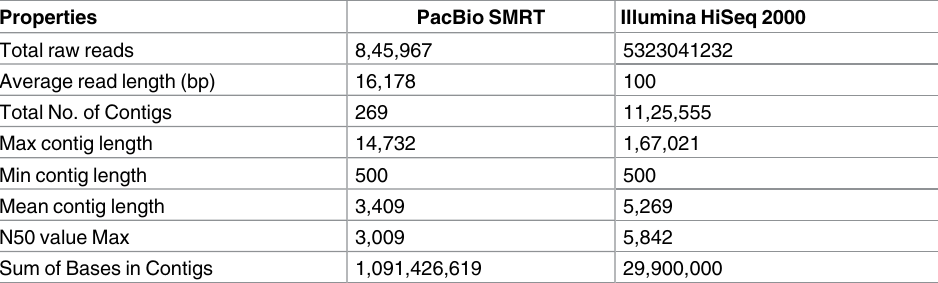
Table 1. Comparison of the Assemblystatistics of PacBio SMRT and Illumina HiSeq 2000 Sequencing of the draft genome of T . indica .